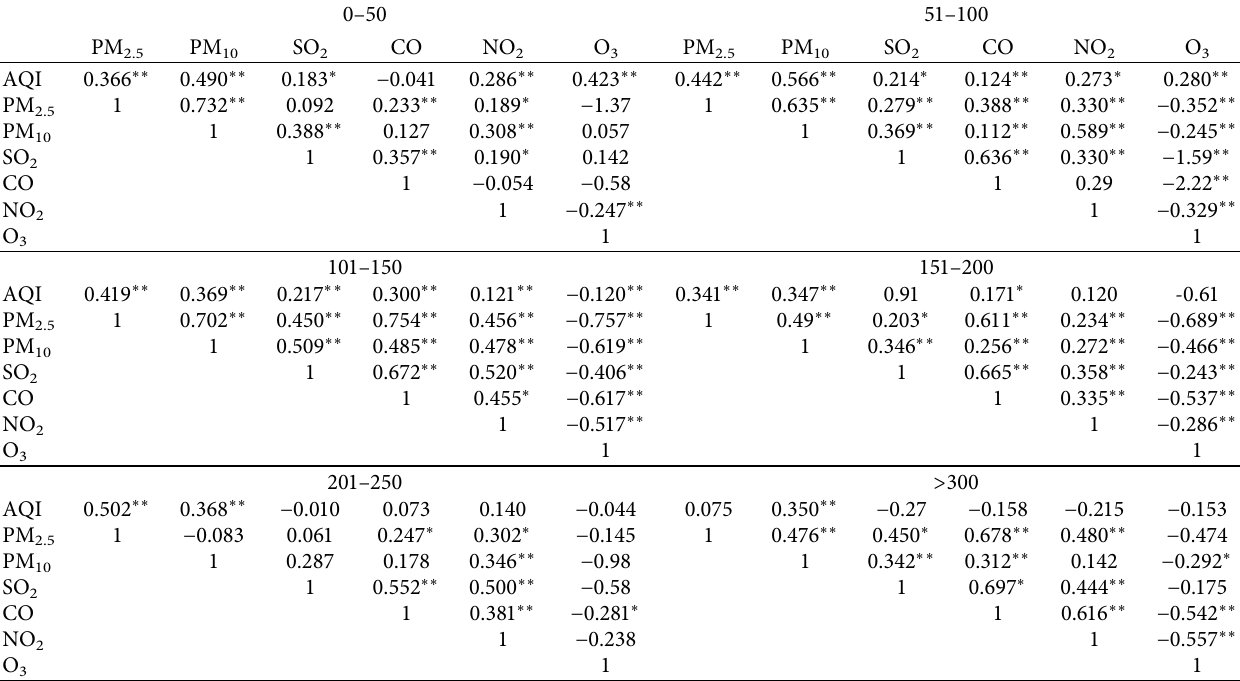
temperature, RH relative humidity, and WS (cid:31) (cid:31) represents a significance level of 0.01 ( P ∗∗